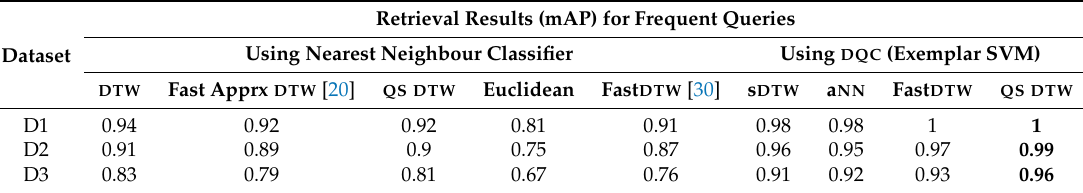
Table 3. Retrieval performance of various methods for frequent